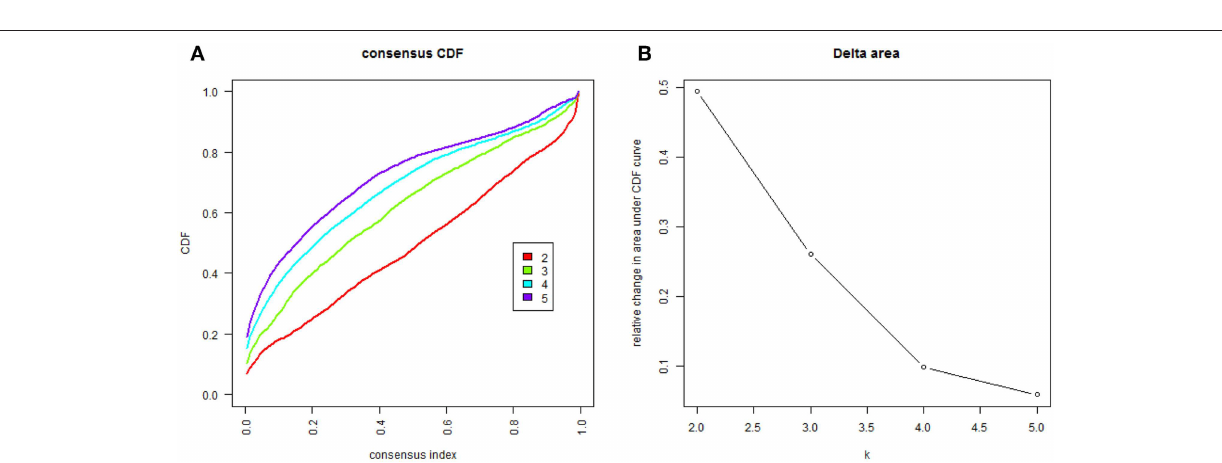
of all tumor samples. The optimal number of clusters was determined by the K value. After assessing the relative change in the area under the cumulative distribution